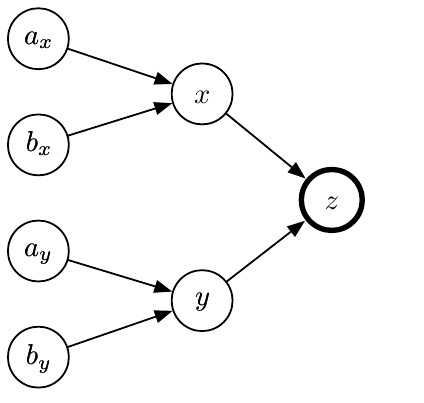
Fig. 5 G I : A DAG to organize the uncertain Algorithm 5: ProcessConstraints ( , ) I uncertain S dependency